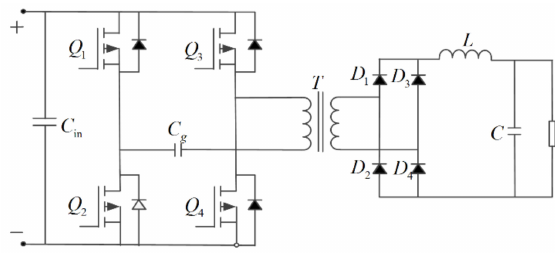
Figure 15. Block diagram of the simplified dc / dc power converter-based load.